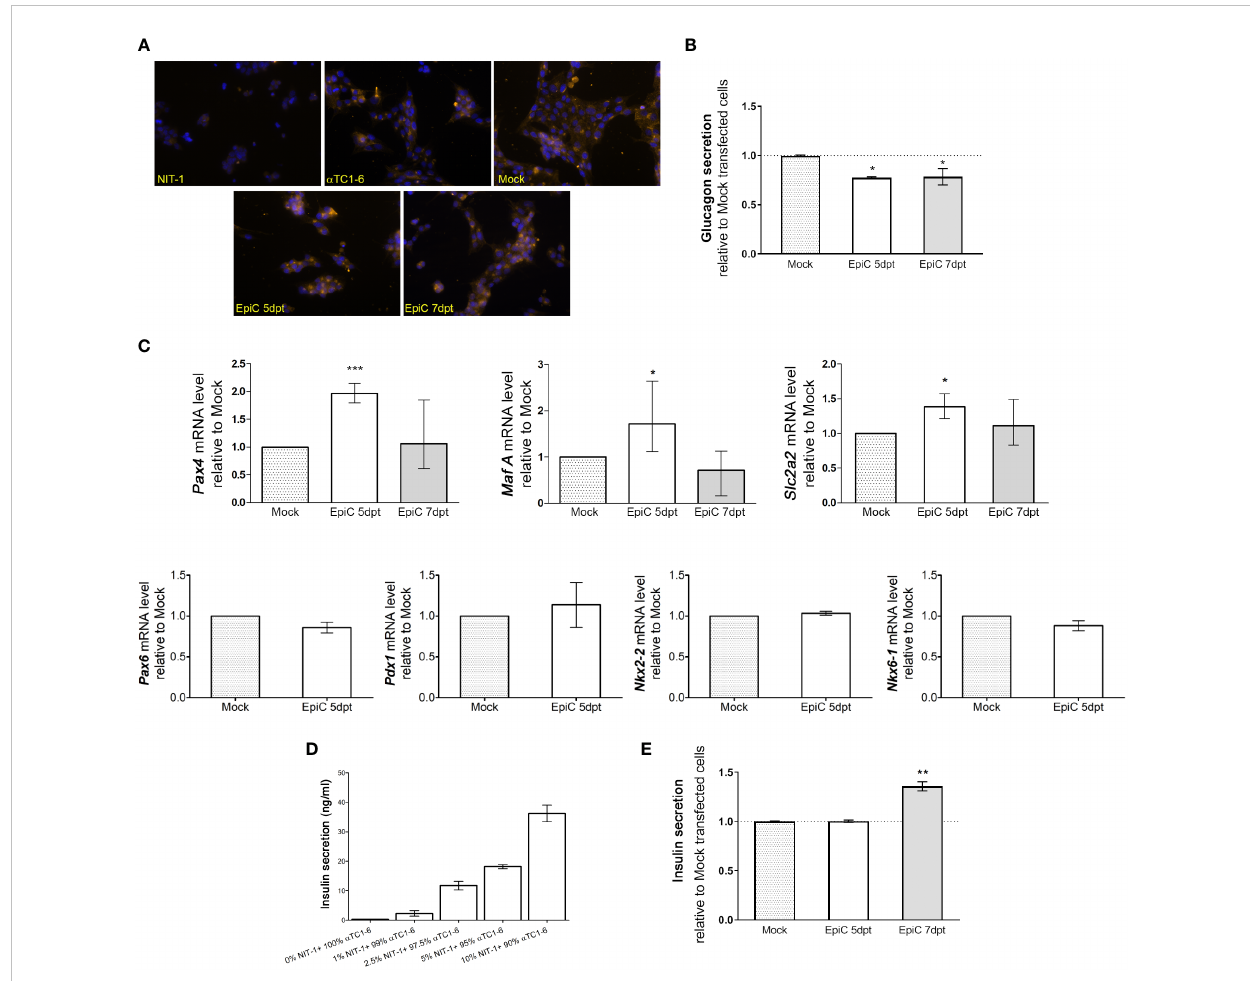
FIGURE 8 Expression changes in hormone secretion and beta cell-related genes in EpiC transfected a TC1-6 cells. (A) Immuno fl uorescence analysis of Mock and EpiC transfected cells with anti-glucagon antibody (light orange fl uorescence) on the 5 th and 7 th day after transfection. Nuclei were stained with DAPI (blue fl uorescence). (B) Glucagon secretion in cell culture media was measured by ELISA on the 5 th and 7 th day after transfection (N=4). (C) Relative mRNA expression level of Pax4 , MafA and Slc2a2 on the 5 th and 7 th day as well as Pdx1 , Pax6 , Nkx2-2 , Nkx6-1 on the 5 th day after transfection related to Mock transfected cells (N=4). The REEP5 mRNA level expression was used as an endogenous control. (D) Glucose-stimulated insulin secretion measured by ELISA assay. The concentration of secreted insulin in cell culture media in a TC1-6 mixed with NIT-1 cell lines in different percentages (0-10%) was determined after adding 30 mM glucose in the KRB buffer. (E) Insulin secretion in a TC1-6 cell culture media was measured by ELISA assay on the 5 th and 7th day after transfection (N=3). The one sample t-test was used for determining statistical signi fi cance, *p ≤ 0.05, **p ≤ 0.01, ***p ≤